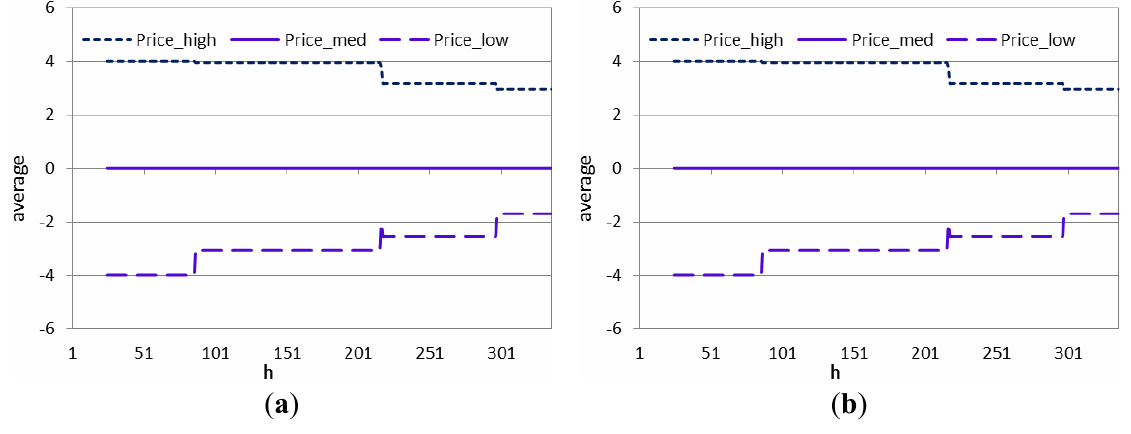
over the previous 24 h and ( b ) Number of SOC,